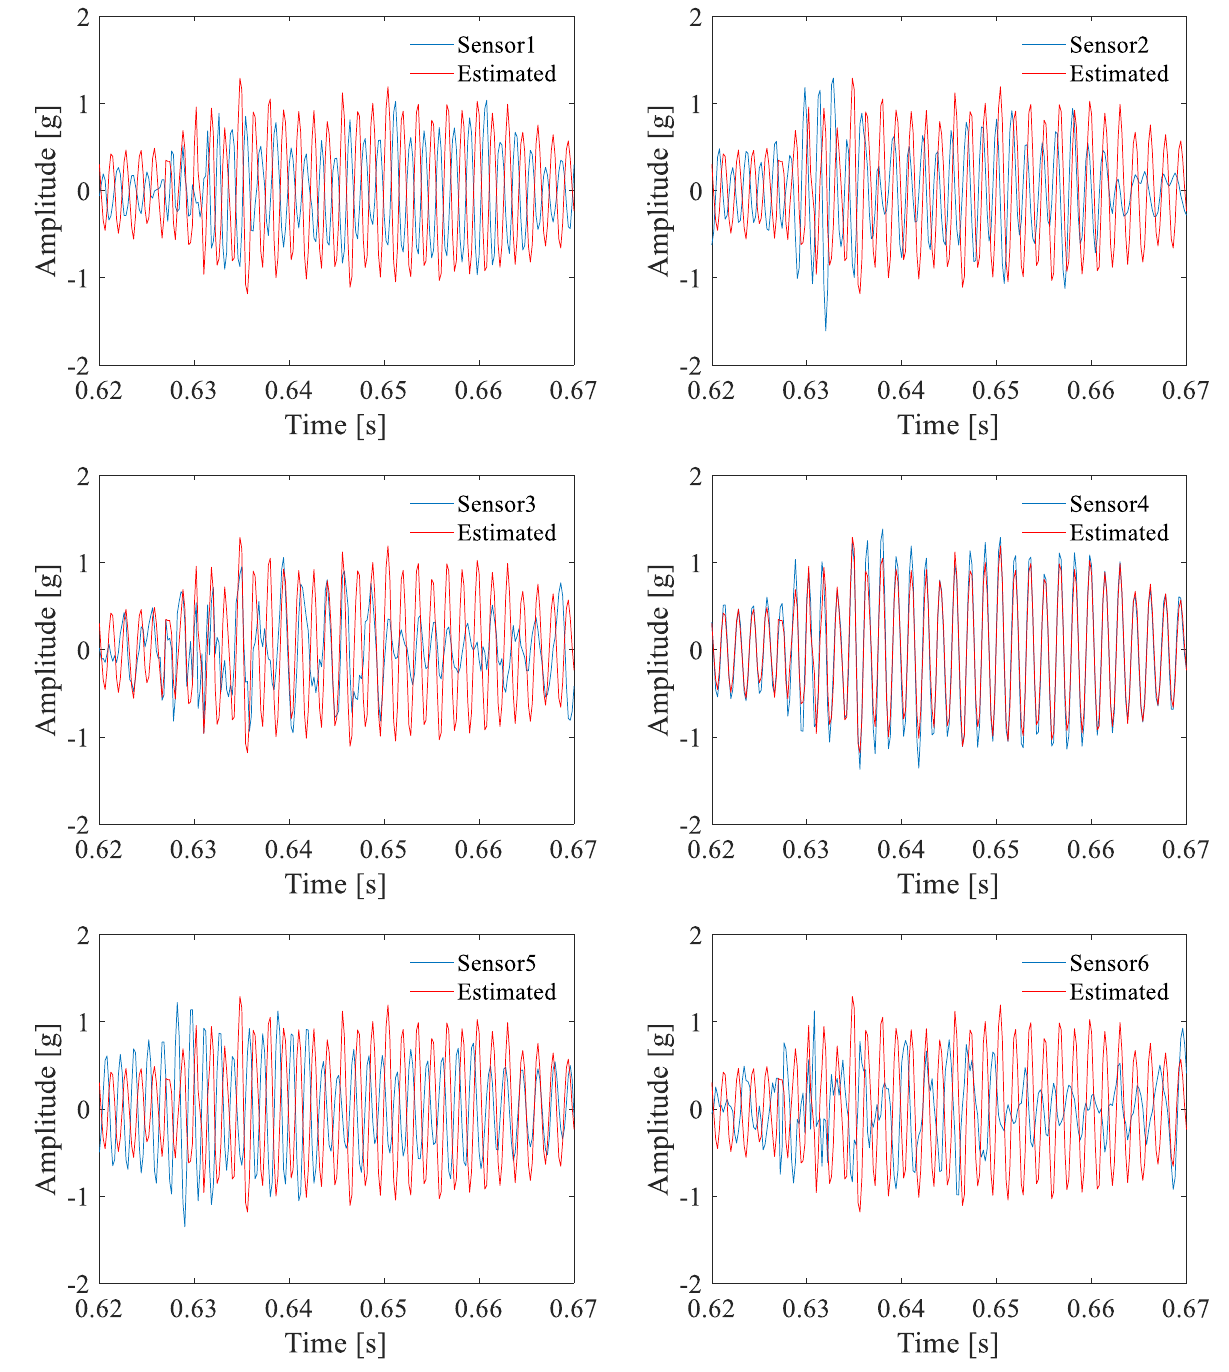
Figure 10. Contrasted results zoomed in 0.62 – 0.67 s in outer race fault experiment. To further validate the effectiveness, order spectrum analysis [37,38] is employed for the collected signals. Figure 11 shows the corresponding envelope order spectrums of those bearing signals. From this figure, BPFO can be clearly identified. In particular, the amplitude of the order spectrum acquired from the fourth signal is higher than the others. It just proves the conjecture that the fourth sensor placement point is the optimal location for this test experiment. Therefore, the conjecture for the optimal sensor in this test process is right. Finally, many independent tests are performed to analyze the correlation between the estimated signal and sensors’ collected signals under different maximum rotation